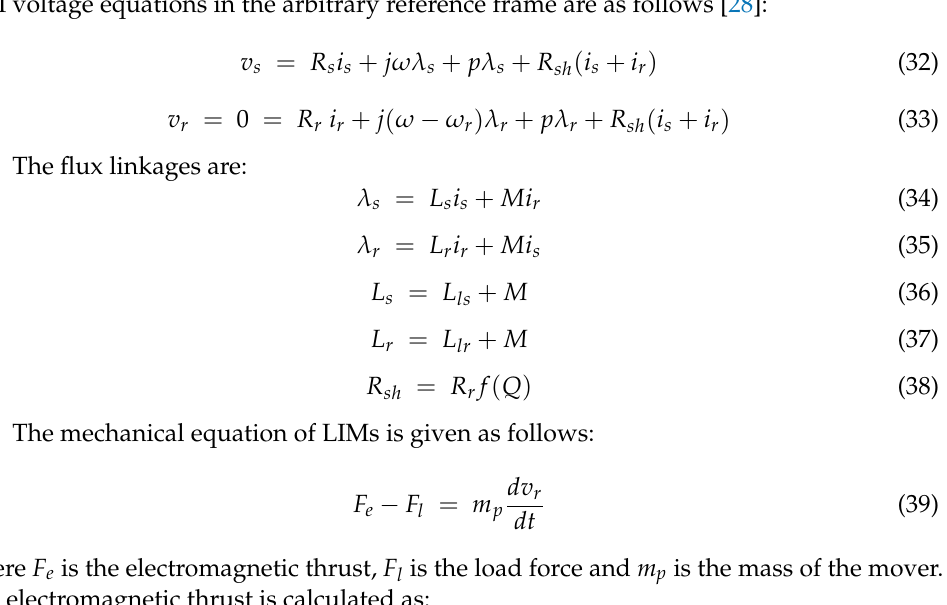
10 of 14 Table 2. Equivalent circuit parameters of the LIM. Parameter 10.3 Ω Figure 6. Magnetic inductance variations versus the velocity.